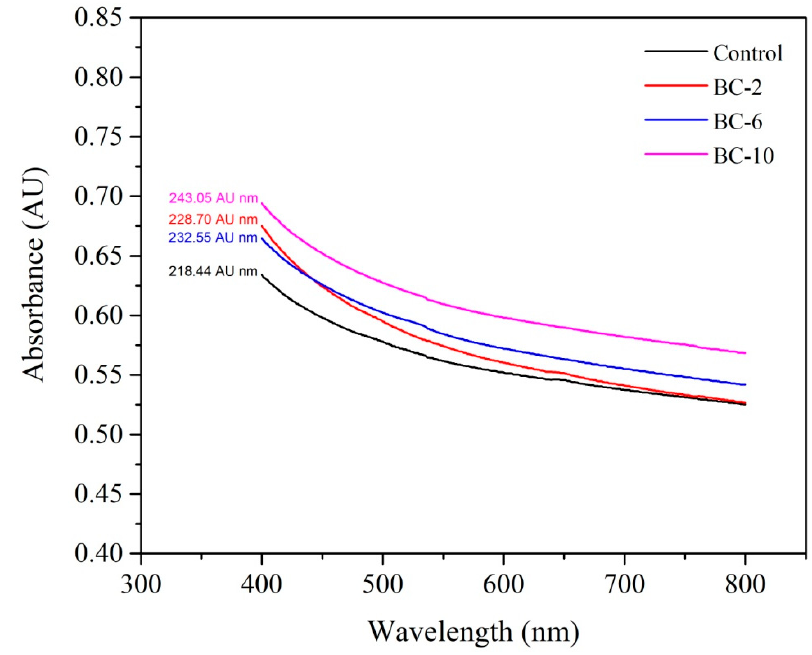
Figure 2. Film opacity of control and biocomposite films.